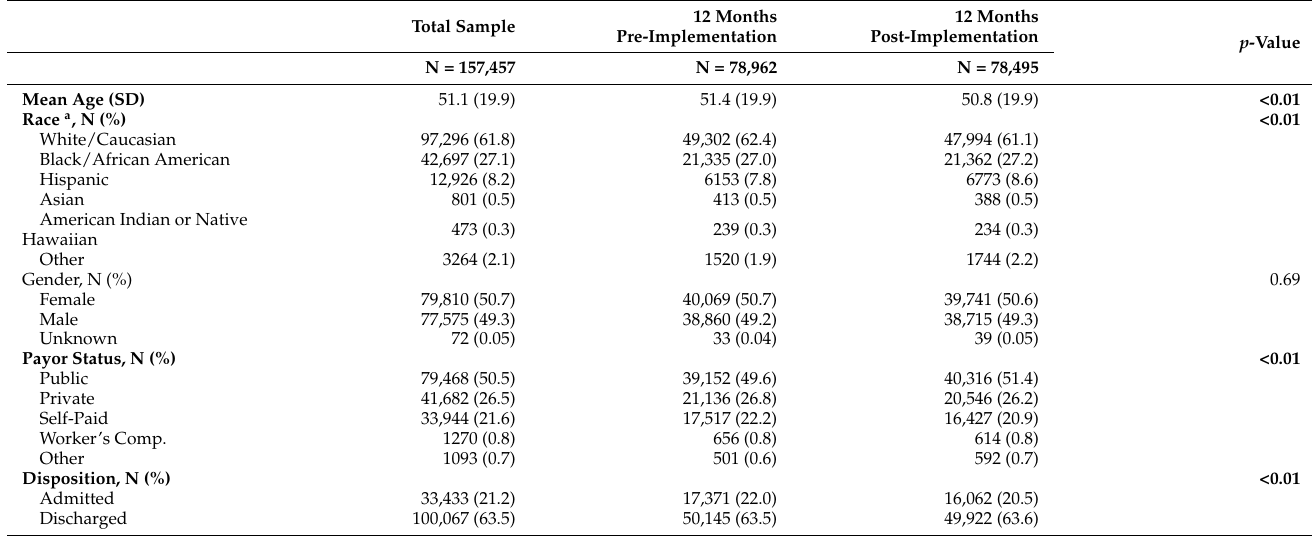
Table 1. Characteristics of Patients who had Emergency Department Encounters in the Pre- and Post-implementation Period.